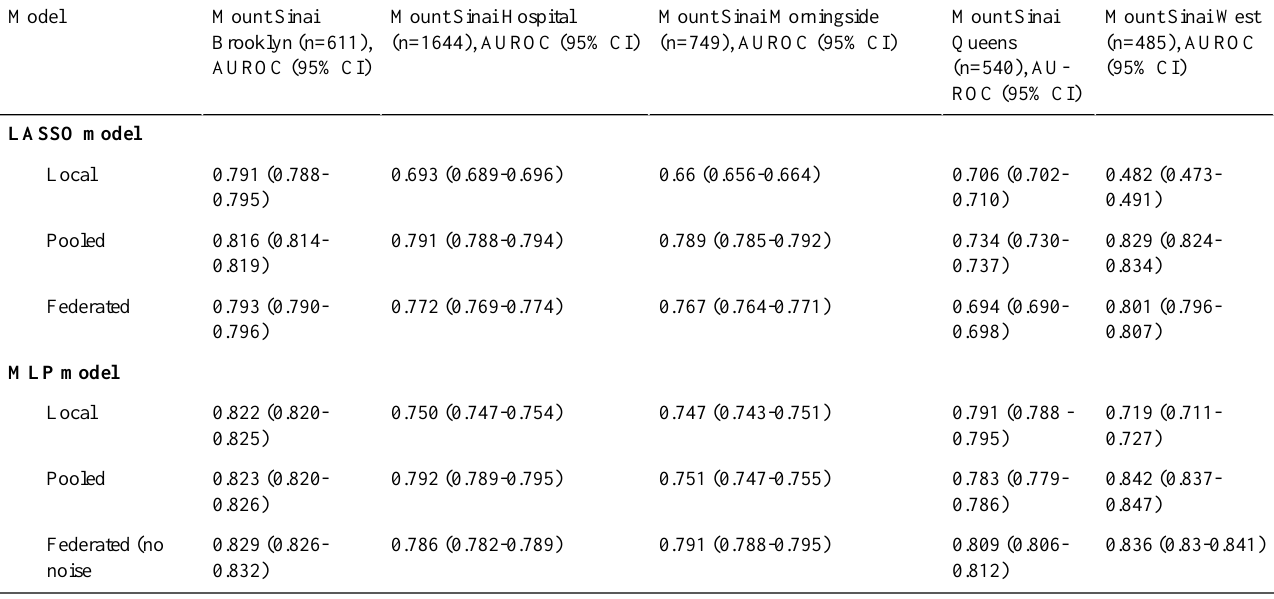
Table 2. Performance of the local, pooled, and federated LASSO a and MLP b models at each site, based on AUROCs c with 95% confidence intervals.